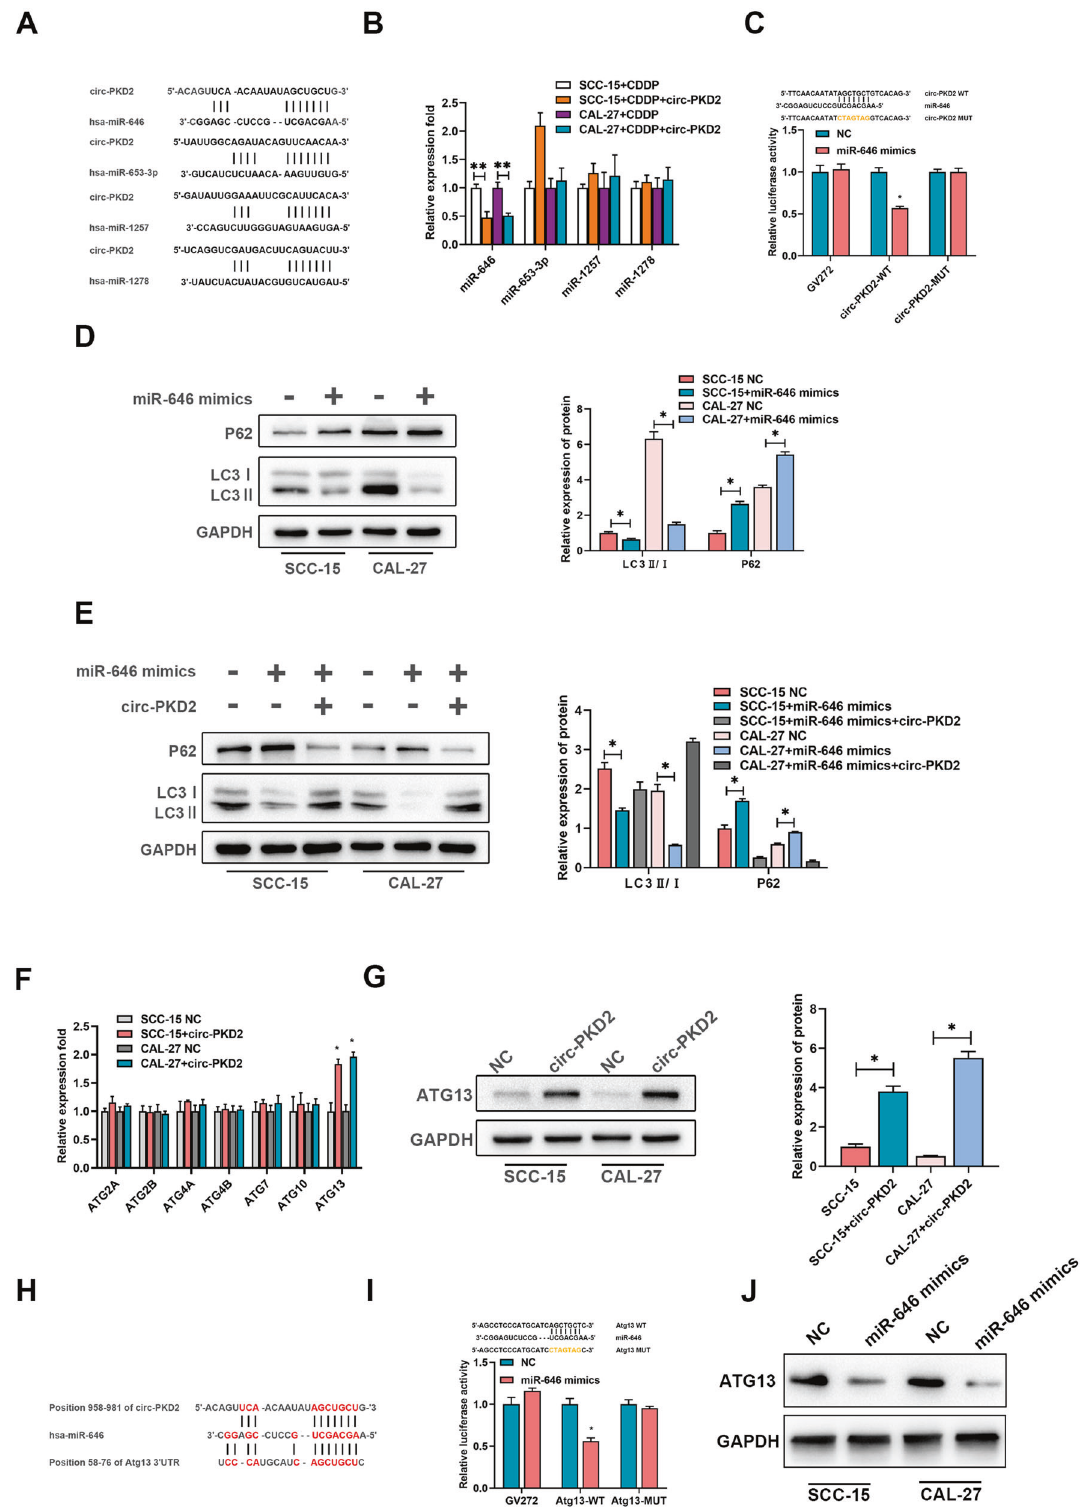
Fig. 3 circ-PKD2 is a molecular sponge for miR-646. A A schematic graph of the four targets miRNAs-binding sequence. B The mRNA expression results of miRNAs measured using real-time PCR in SCC-15 and CAL-27 cells stably transfected with circ-PKD2 overexpression and controlled with cisplatin for 24 h. C The luciferase activity reporter assay results show the miR-646 binding site on circ-PKD2 predicted using a Circular RNA Interactome. D Western blotting results of cells transfected with miR-646 mimics and NC to reveal the autophagy-related proteins. E Western blotting results of cells co-transfected with miR-646 and circ-PKD2 to examine the protein levels. F The mRNA expression results of the autophagy-related genes were measured using real-time PCR in SCC-15 and CAL-27 cells transfected with circ-PKD2 overexpression and their control. G The protein levels of ATG13 in SCC-15 and CAL-27 cells transfected with circ-PKD2 and their control. H Illustration of the base pairing between miR-646 and circ-PKD2, and miR-646 and ATG13. I The reporter activity between miR-646 and Atg13 after normalization with respect to Renilla luciferase activity. * p < 0.05, ** p < 0.01. Cell Death and Disease (2022)